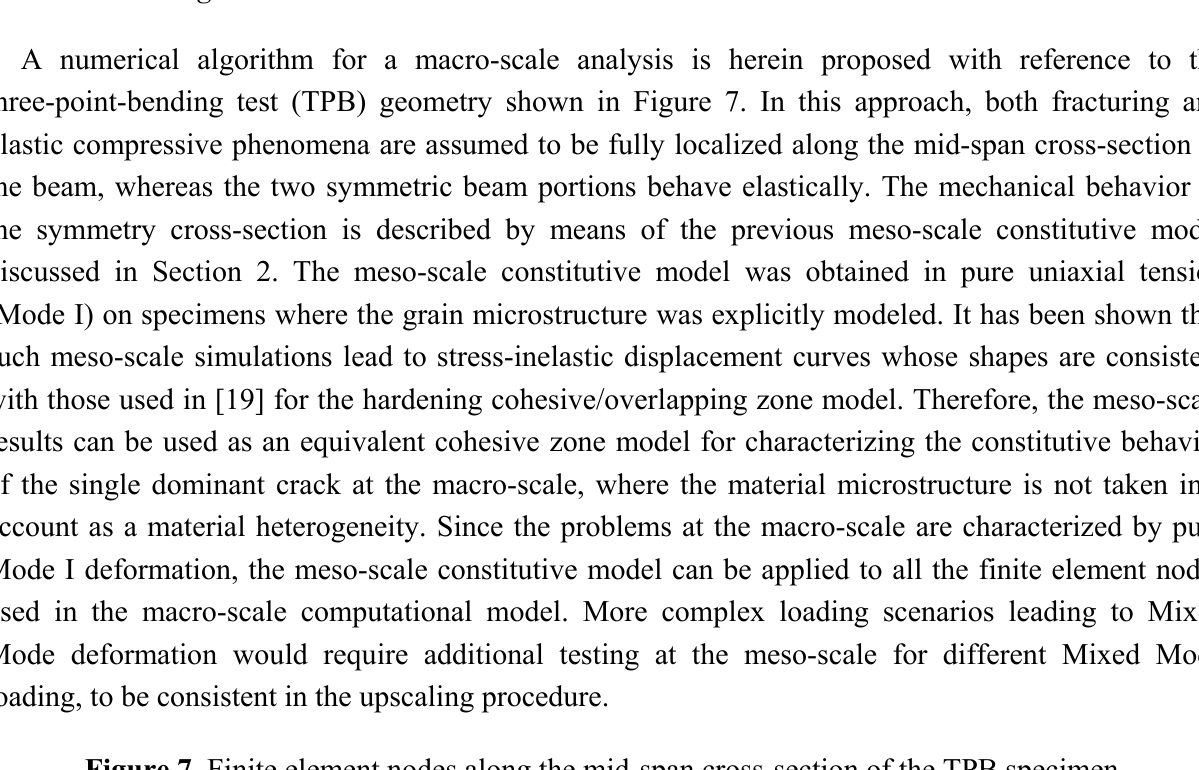
Figure 7. Finite element nodes along the mid-span cross-section of the TPB